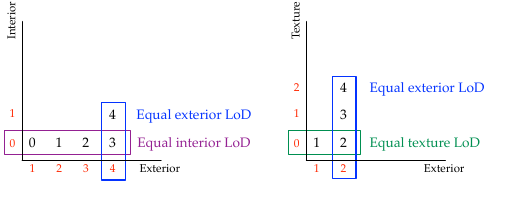
Figure 7: The two elements (exterior and texture) of the LoD paradigm of BLOM progress separately. It is similar as CityGML